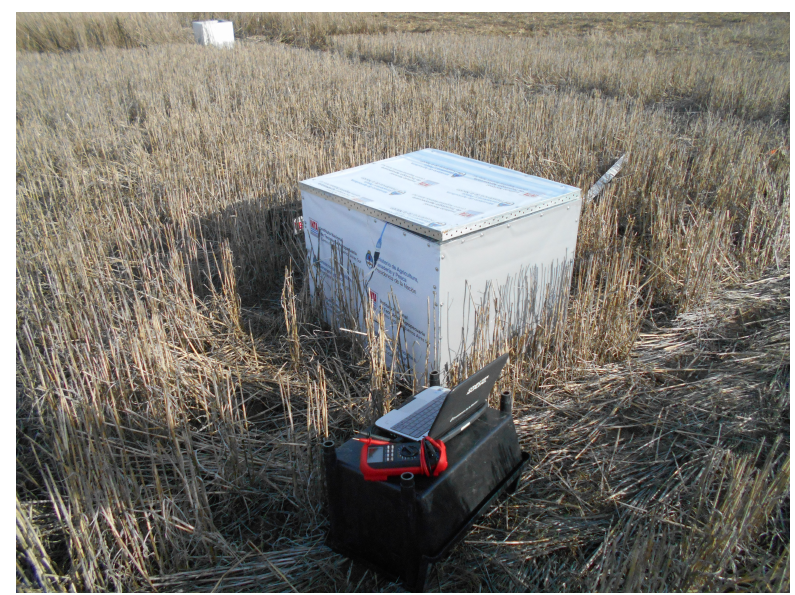
Figure 8. The implemented scanner in outdoor environment inside the closed box.